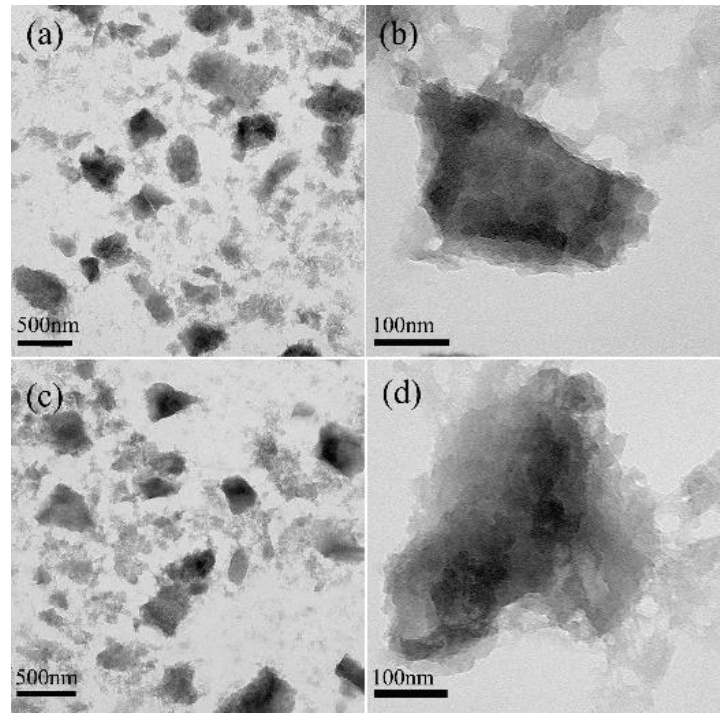
Figure 1. TEM images of ( a , b ) MIL-100(Al) gels. ( c , d ) DOX-loaded MIL-100(Al) gels.